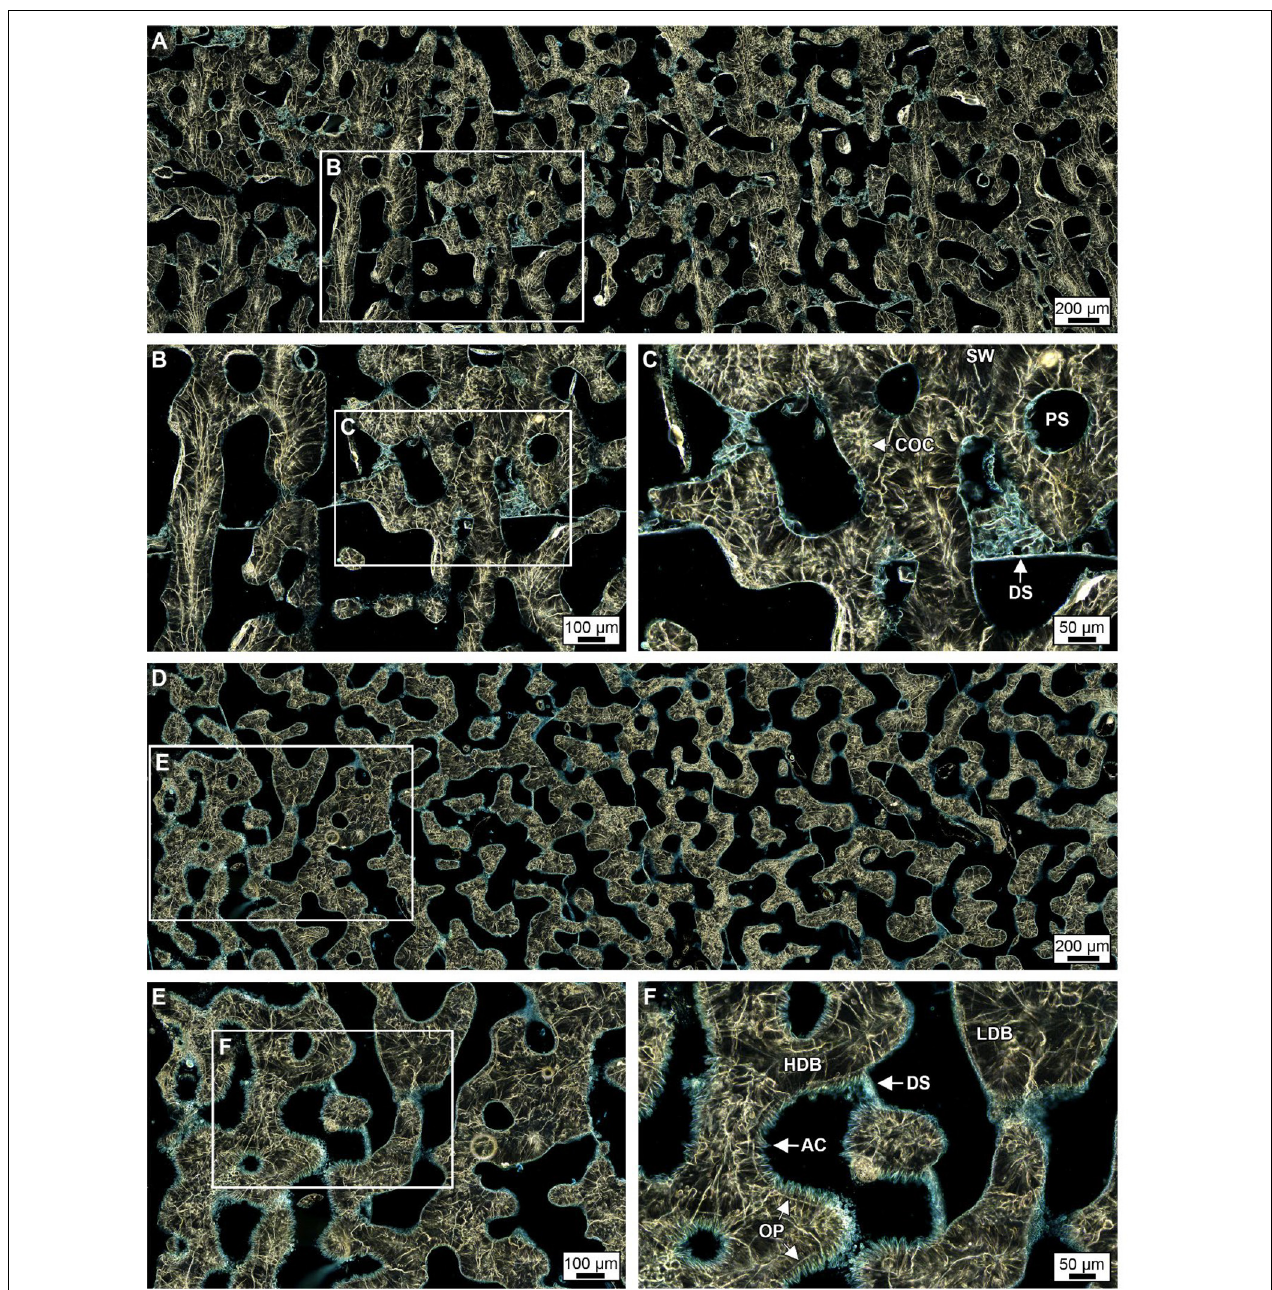
FIGURE 7 | Ring aperture contrast images of crystalline structure and diagenesis in high- and low-density bands (HDBs and LDBs) within the uppermost (top 6 cm, A–C ) and lowermost 6 cm of Core 4 (D–F) . (A–C) Overview of a HDB and LDB transition region in the uppermost region of Core 4 with enlargements showing original skeletal pore spaces (PS) with little to no occlusion by acicular aragonite (AC, see enlargement in C ) and chunks of skeletal debris bound by dissepiments (DS). At the bottom of Core 4 (D–F) , extensive diagenetic alteration occurs within discrete HDB stratigraphic intervals with AC partially occluding pore spaces. In addition, diagenetic AC are bound by dissepiments at the transition from HDB to LDB, which is consistent made at the bottom of Core 3 ( Figure 5